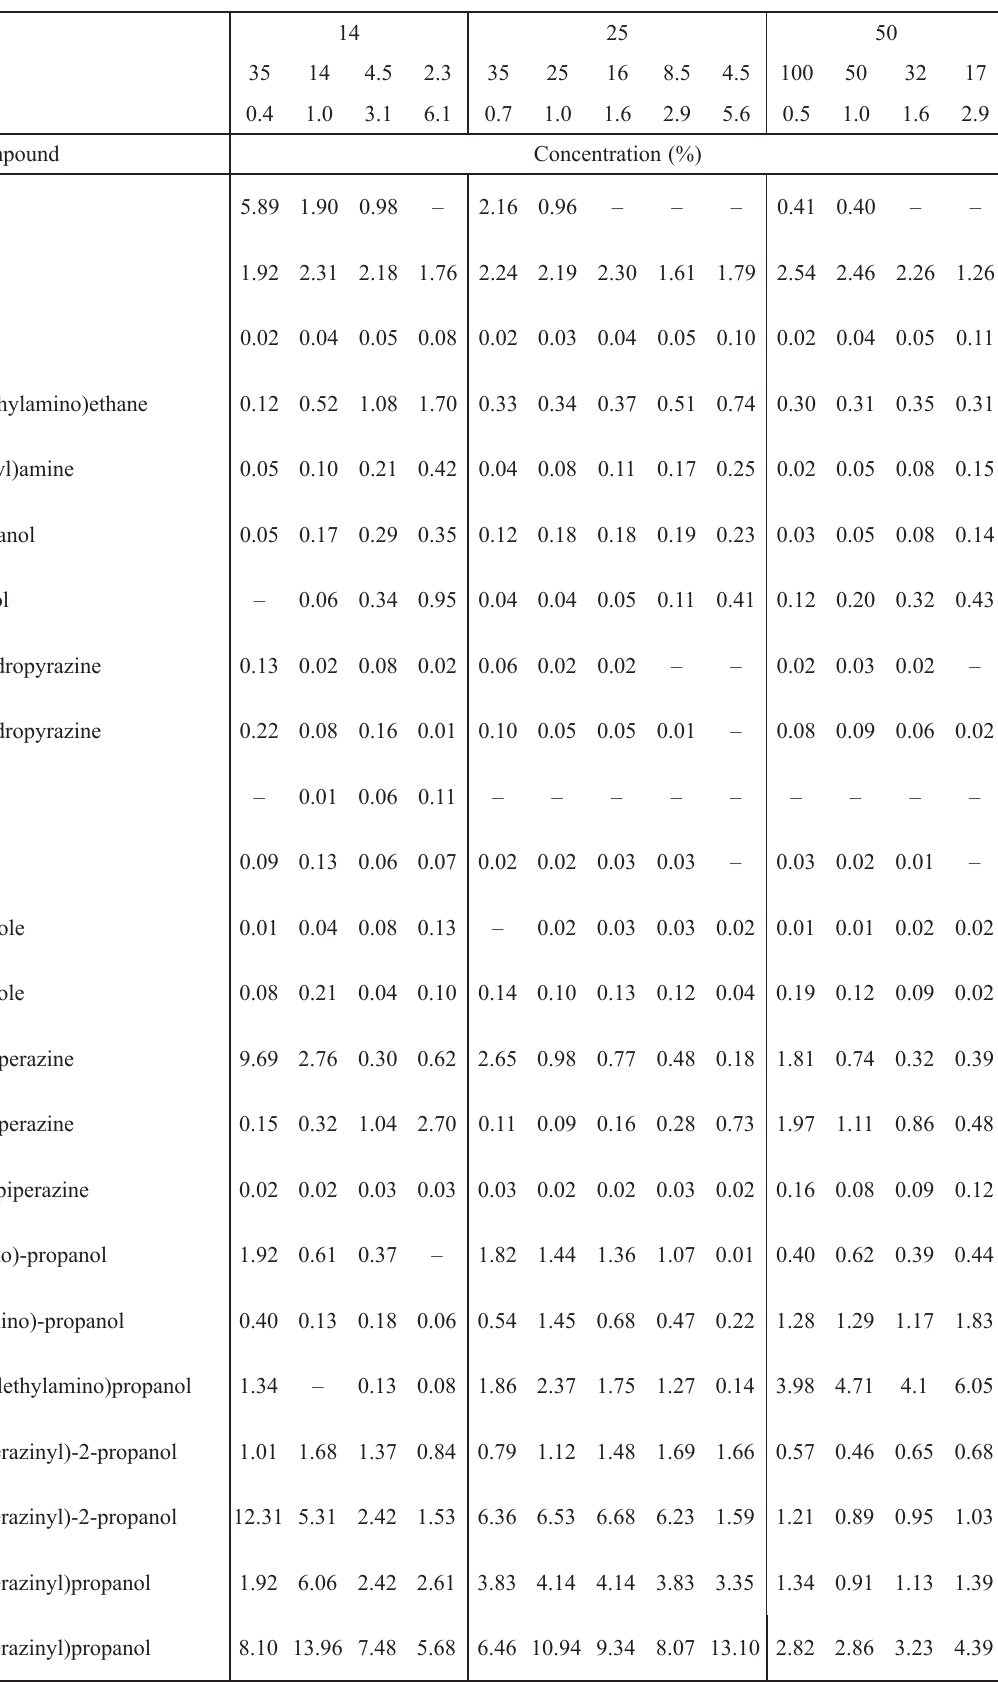
Table 1 – Concentration of other identified by-products (without DMPIPs) formed during the reductive amination of acetol with ammonia in the gas phase over nickel catalyst. Conditions: 130 °C; WHSV = 0.078 h –1 ; total conversion of